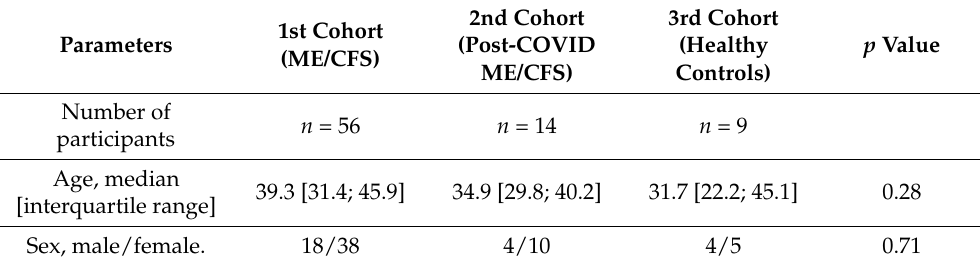
Table 2. Characteristics of the participants in ME/CFS, post-COVID ME/CFS, and controls cohorts.